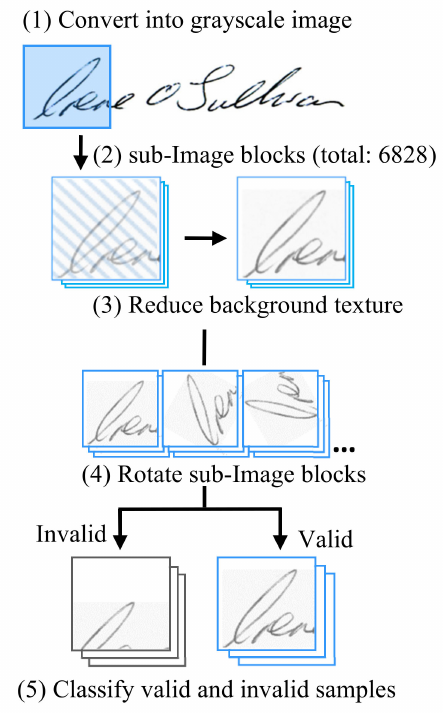
Figure 3. Preprocessing to increase the sample size. Table 1. The rotation angle for data